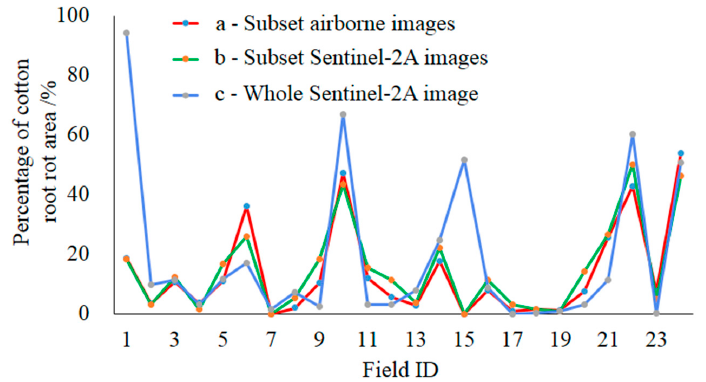
Figure 7. Comparison of cotton root rot area for 24 cotton fields in different classification maps: (a) map generated by field subset airborne images; (b) map generated by field subset Sentinel-2A images; (c) map generated by whole study area Sentinel-2A image.